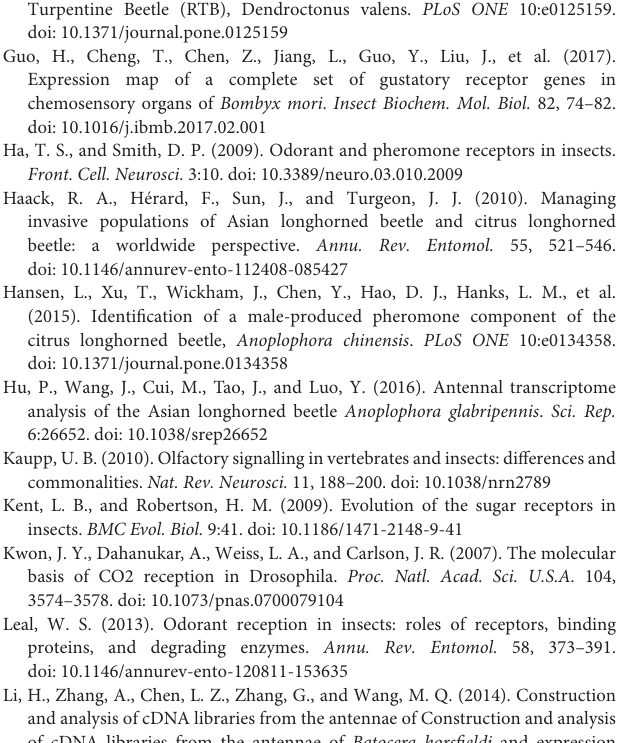
Table S5 | Comparative overview of Anoplophora chinensis odorant receptor genes identified in this study and Anoplophora glabripennis OR genes reported in Mitchell et al. (2017)